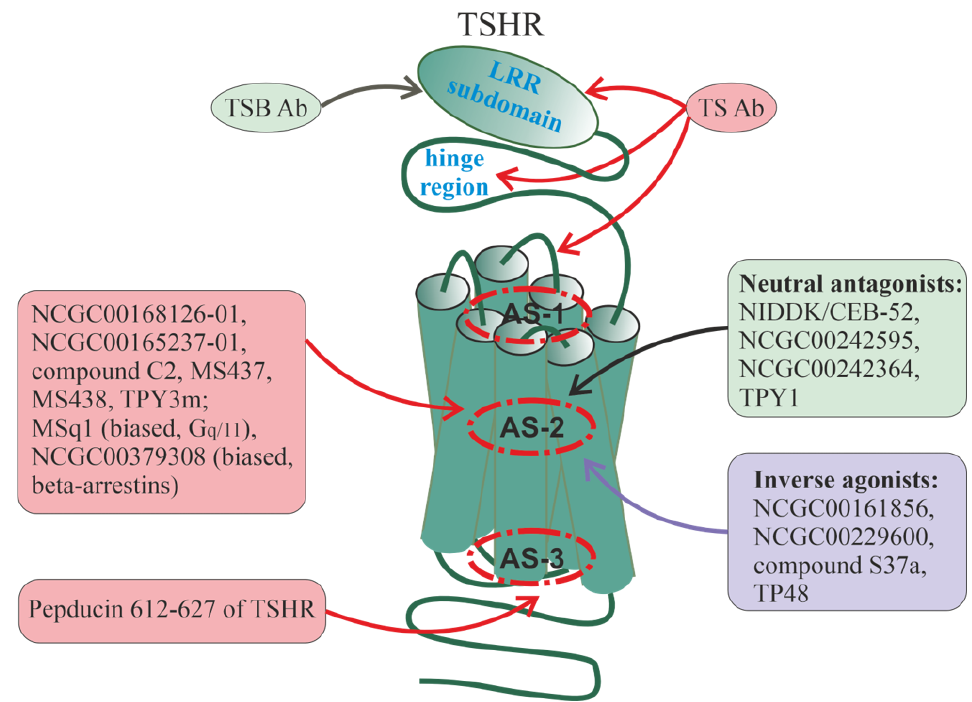
Figure 4. Allosteric regulators of thyroid-stimulating hormone receptor. The TSHR belongs to a family of class A GPCRs having a large extracellular domain in which an orthosteric site is located and which is a target for autoantibodies. Most of the small regulators of TSHR bind to allosteric sites located in the cavity of the AS-2 locus or slightly higher in the lower portions of the AS-1 locus. The following low-molecular-weight compounds specifically interact with allosteric sites in the AS-2 locus: compound C2, NCGC00168126-01 and its analog NCGC00165237-01 (full allosteric TSHR- agonists), MS437, MS438 (biased allosteric TSHR-agonists, did not affect G i -proteins), TPY3m (biased allosteric TSHR-agonist, mainly activates G s -proteins), MSq1 (biased allosteric TSHR-agonist, mainly activates G q/11 -proteins), NCGC00379308 (biased PAM, predominantly activates β -arrestins), TPY1, NIDDK/CEB-52 and its analogs NCGC00242595 and NCGC00242364 (allosteric TSHR-antagonists), NCGC00161856, NCGC00229600, compound S37a, and TP48 (allosteric inverse TSHR-agonists). Pepducin 612–627(Palm) (ICL3 of TSHR) interacts with the intracellular allosteric site and functions as an allosteric TSHR-agonist. Stimulating TSHR autoantibodies (TSAb) interact with the LRR subdomain, hinge region, and ECLs. Blocking TSHR autoantibodies (TSBAb) mainly interact with the N-terminal and central portions of the LRR subdomain. Allosteric regulators that increase receptor activity (full agonists and PAMs) are placed in red squares, allosteric regulators with neutral antagonist activity are placed in green squares, while allosteric regulators with inverse agonist activity are placed in blue